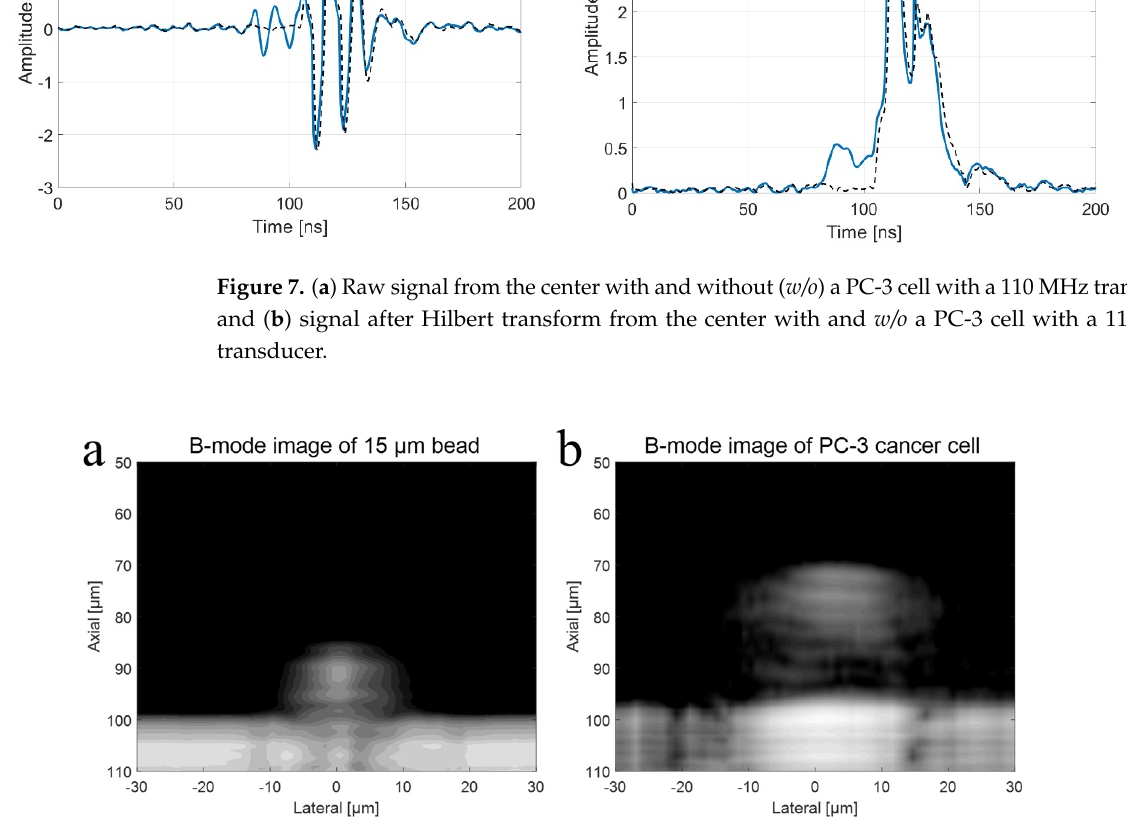
Figure 8. ( a ) B-mode imaging of a 15 μ m bead with a 410 MHz transducer, and ( b ) B-mode imaging of a PC-3 cell with a 410 MHz transducer.